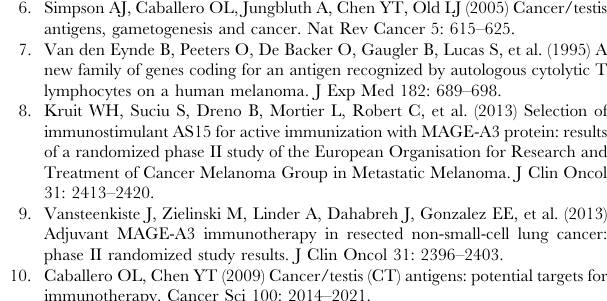
Table S1 Primers for MAGE genes for rt-PCR. Table S2 MAGE antibodies and conditions for IHC. Table S3 MAGE antigen status in ovarian